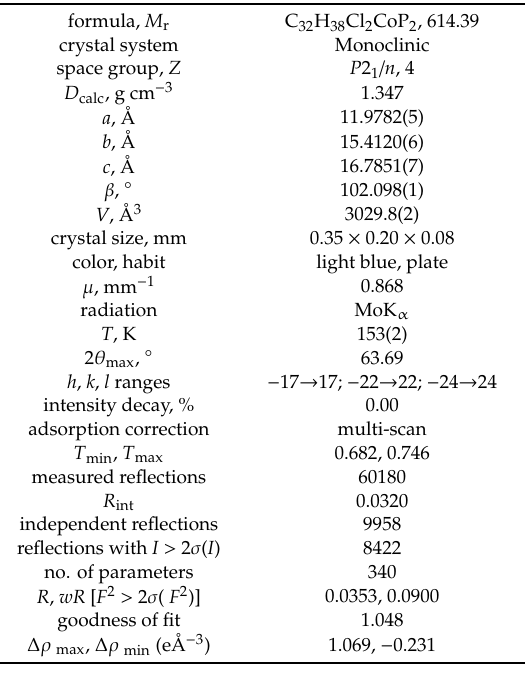
Table 3. Crystallographic data, data collection details, and results of refinement for complex 1